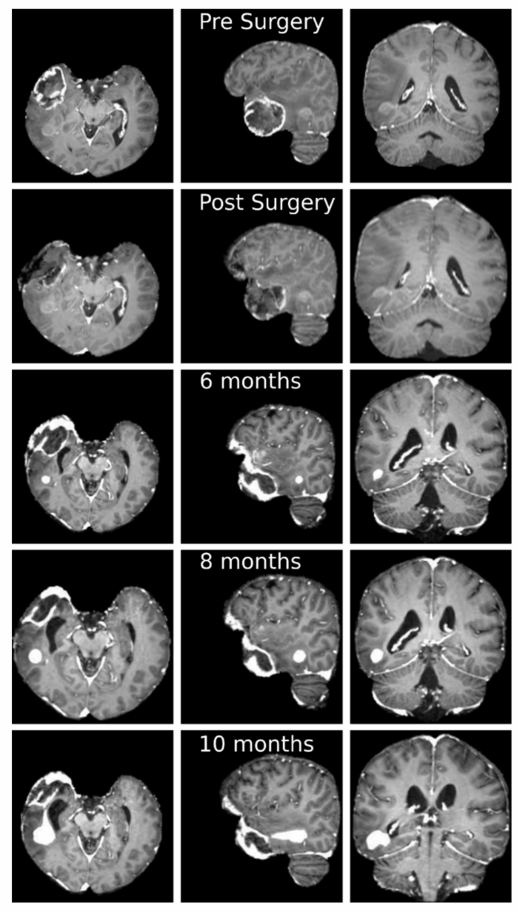
Figure 2. Axial (first column), sagittal (second column) and coronal (third column) slices of the T1-weigthed post contrast administration MRI at different temporal stages. First row: before surgery; second row: after surgery; third row: 6 months after surgery; fourth row: 8 months after surgery; fifth row: 10 months after surgery. It is possible to appreciate the gross total resection of the temporal pole lesion and a progressive volumetric increase of the posterior temporal mass, with change in contrast enhancement characteristics, from the sixth month after